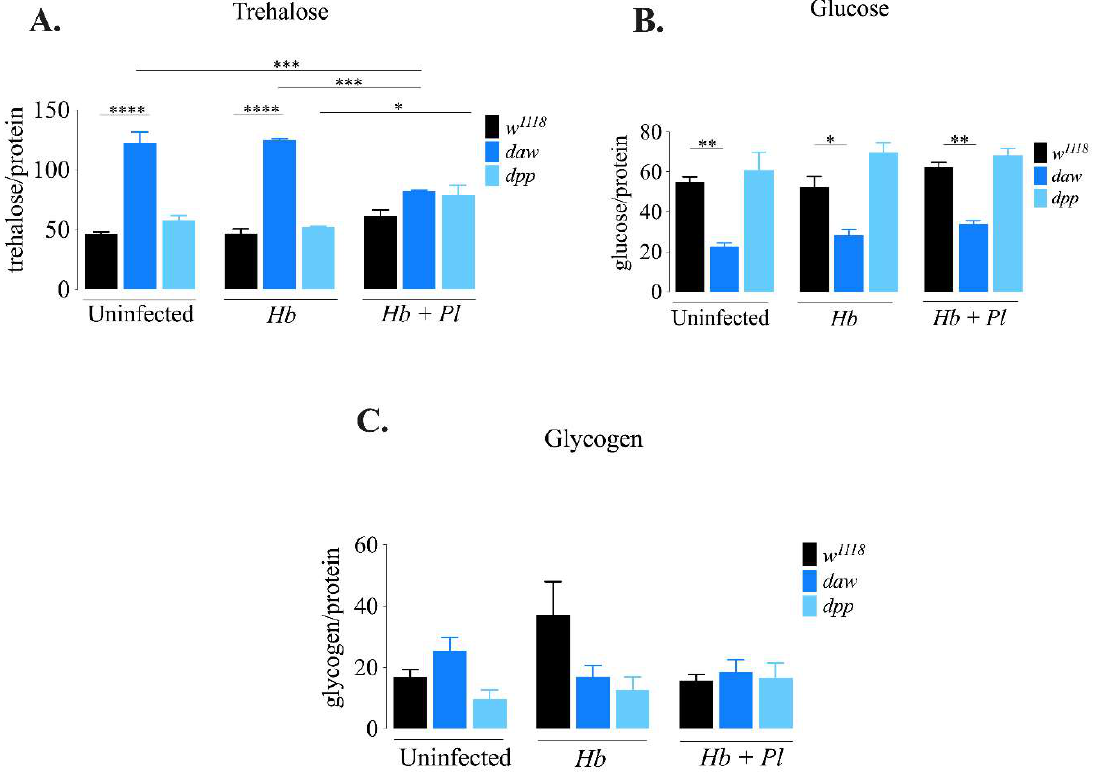
Figure 1. Carbohydrate metabolism in Drosophila melanogaster TGF-ß mutant larvae 24 h after infection with axenic ( Heterorhabditis bacteriophora , Hb ) or symbiotic ( Heterorhabditis bacteriophora + Photorhabdus luminescens , Hb + Pl ) nematodes. ( A ) Levels of trehalose in daw and dpp mutant larvae infected with parasitic nematodes. Trehalose levels are elevated in uninfected daw mutant larvae and in daw mutants infected with axenic H. bacteriophora nematodes compared to their respective background controls ( w 1118 ) (**** p < 0.0001). In addition, trehalose levels are decreased in daw mutant larvae infected with symbiotic nematodes compared to the uninfected daw mutants (*** p = 0.0004) and daw mutants infected with axenic nematodes (*** p = 0.0002). Trehalose content in dpp mutant larvae infected with H. bacteriophora symbiotic nematodes is significantly higher than in dpp mutants infected with axenic nematodes (* p = 0.0272). ( B) Levels of glucose in infected daw and dpp mutant larvae. Levels of glucose are reduced in uninfected daw mutant larvae (** p = 0.0017) and those infected with either axenic (* p = 0.0386) or symbiotic H. bacteriophora (** p =0.0036) compared to their background controls ( w 1118 ). ( C ) Levels of glycogen in infected daw and dpp mutant larvae. There is no significant change in the levels of glycogen in TGF-β mutant larvae upon infection with axenic or symbiotic nematodes. The experiments were performed in biological duplicates and repeated three times (N=42- 54).